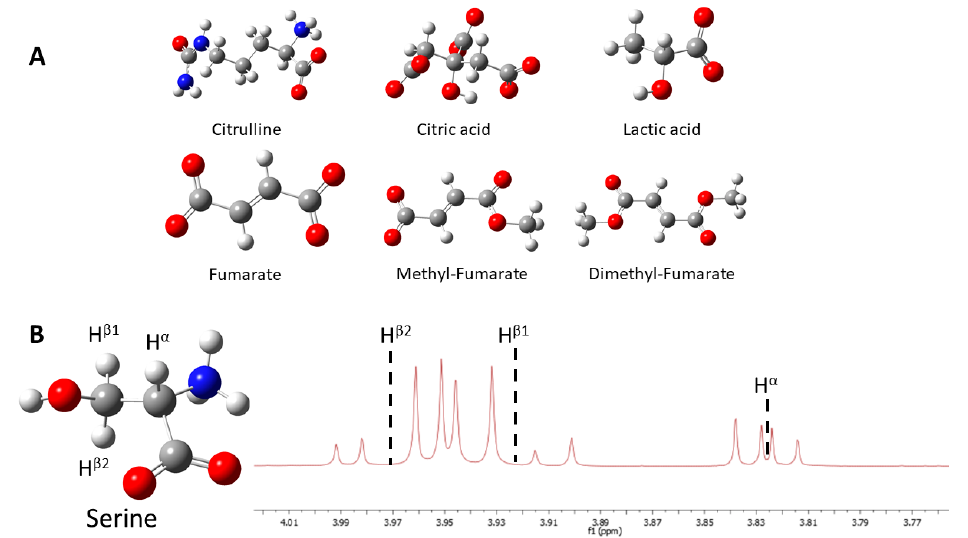
Figure 1. ( A ) The structures of theoretically studied endogenous molecules. ( B ) The structure of serine with its three-spin system and proton spectrum.